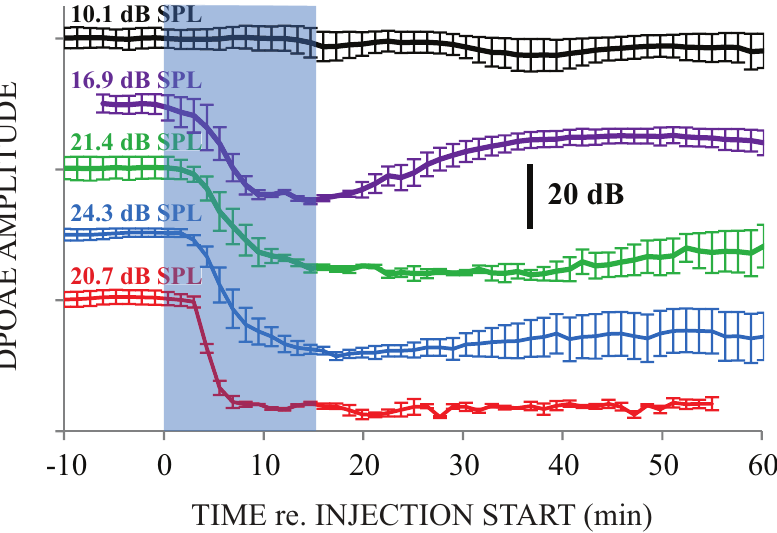
Fig 5. Distortion product otoacoustic emission(DPOAE) amplitudes at 2 f 1 - f 2 evokedfrom f 2 (cid:25) 6 kHz, f 2 / f 1 = 1.2 kHz, L 2 = 50 dB, L 1 = 10 dB re. L 2 . The blue rectangle identifiesthe 15 minuteinjection.Valuesto the left of the rectangleare averageDPOAE amplitudes from ~10 minutesof pre-injectiondata. The microphone noisefloor wasapproximately -20 dB SPL. Measurement rankingson the y-axis weredetermined by the effect of the ototoxicsolution:measurements associated withthe smallesteffect are at the top of the figure,progressing to the largesteffect at the bottom of the figure.M β CDtotallyabolishedDPOAEs, whilethe remainingototoxic solutionscausedtransient declinesin amplitudesthat did not returnto pre-injectionlevels. N = 3 for each